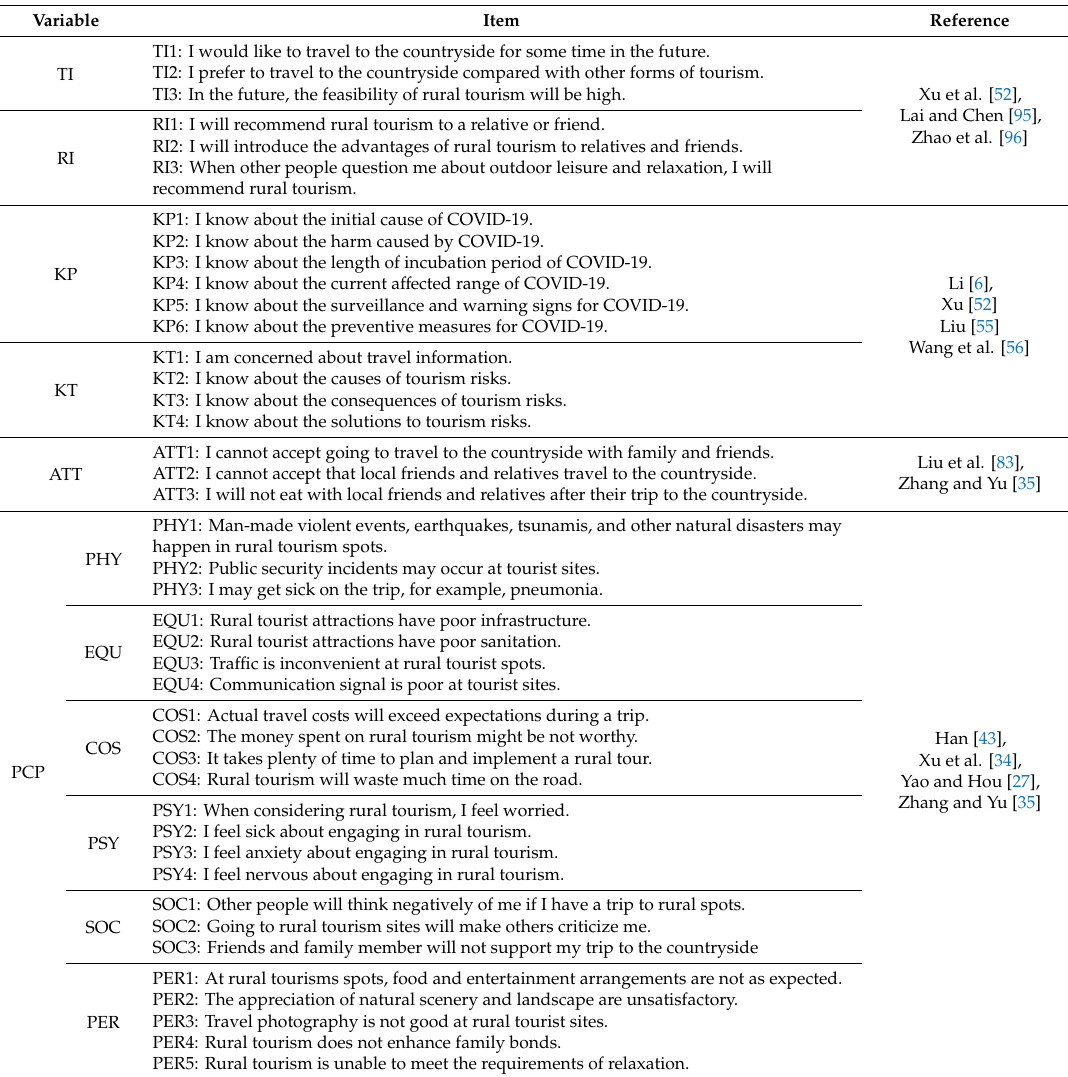
Table 2. Questionnaire